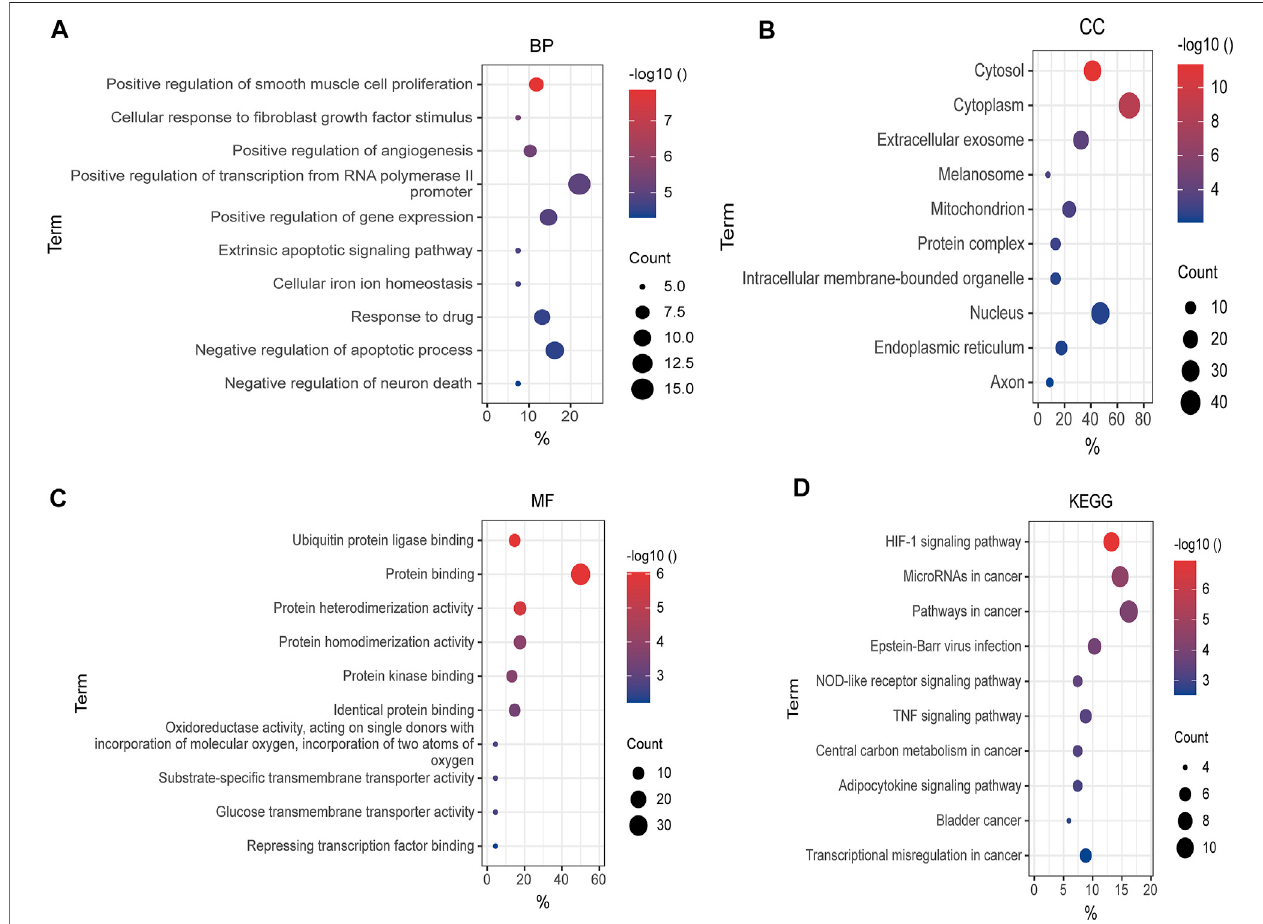
FIGURE 4 | GO and KEGG enrichment analysis of DEFRGs. (A) GO enrichment analysis of DEFRGs in the biological process category (BP); (B) the cellular component category (CC); (C) the molecular function category (MF); (D) KEGG enrichment analysis of DEFRGs. DEFRGs, differentially expressed FRGs.